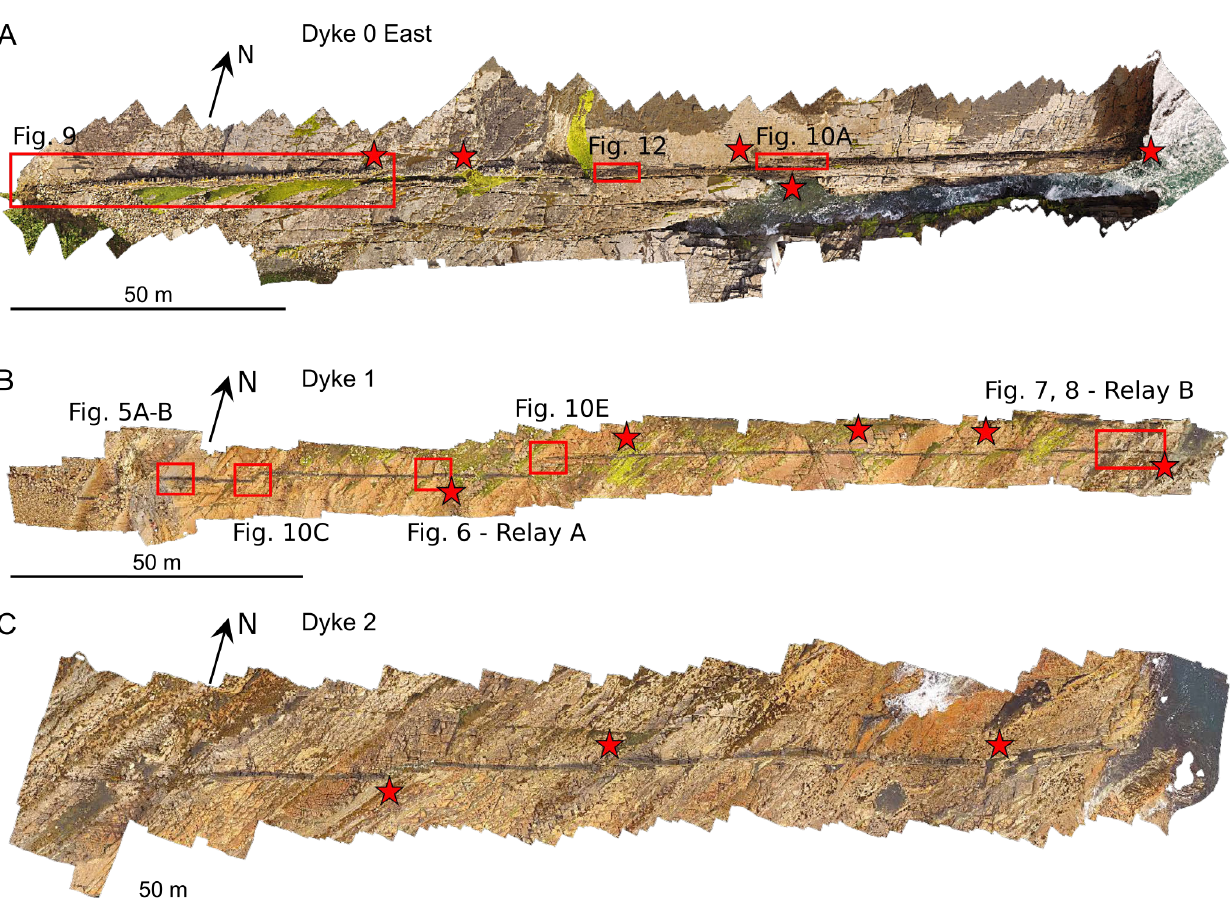
Figure 3: Orthorectified photo mosaics of the three dykes studied in detail. Dyke 0 East has a total exposed length of 225 metres, Dyke 1 has a length of 205 metres and Dyke 2 has a length of 186 metres. Note the segmentation of all three dykes, with the majority of segments left stepping, although right-steps do occur. Traces of bedding planes in the host rocks can be seen striking NE–SW. Red boxes mark the locations of the relay zones selected for detailed analysis in this paper. Red stars mark other locations where evidence for segment floors and/or roofs can be seen, although not documented in detail in this paper. High-resolution orthomosaics can be found at